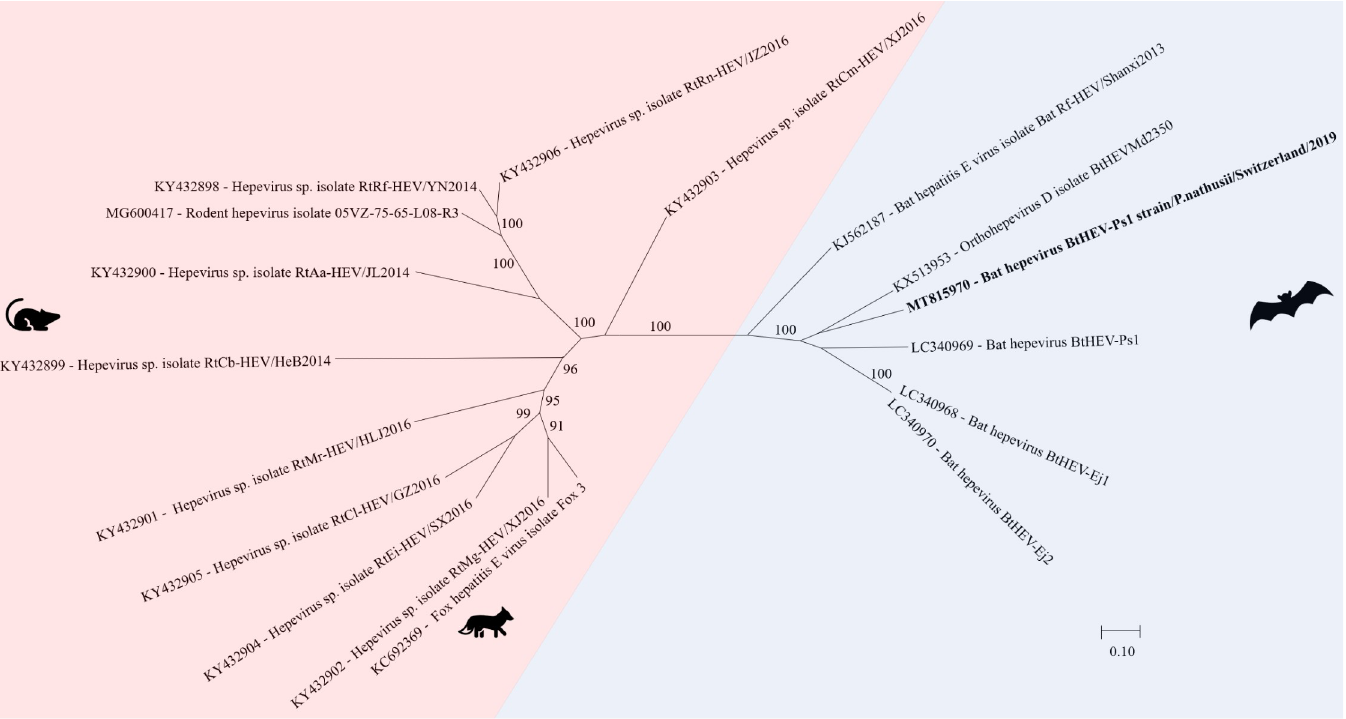
Fig 11. Phylogenetic analysis of full and partial genome of hepeviruses. The sequence obtained in this study (GenBank acc. numbers MT815970) is shown in bold. Sequences of non-bat associated viruses are marked with a red background and those of bat associated viruses with a blue background. The pictograms on the right side represent the species in which the virus was detected. Sequences were aligned using Muscle. For phylogenetic analysis, the Maximum likelihood tree with 1’000 bootstraps was used. Only values � 70% are displayed.